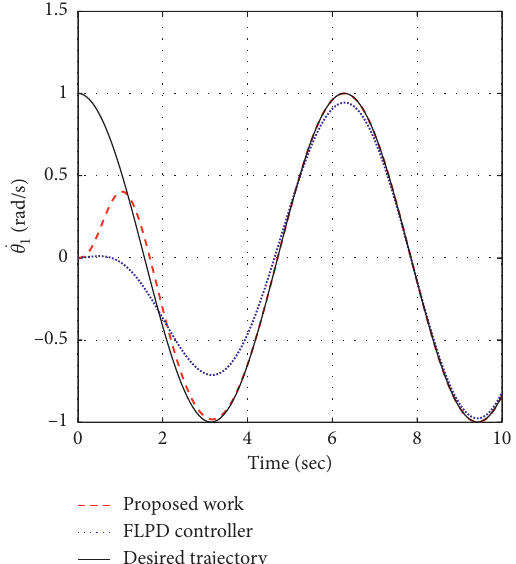
Figure 9: Trajectory tracking of the joint angular velocity for the flexible link.